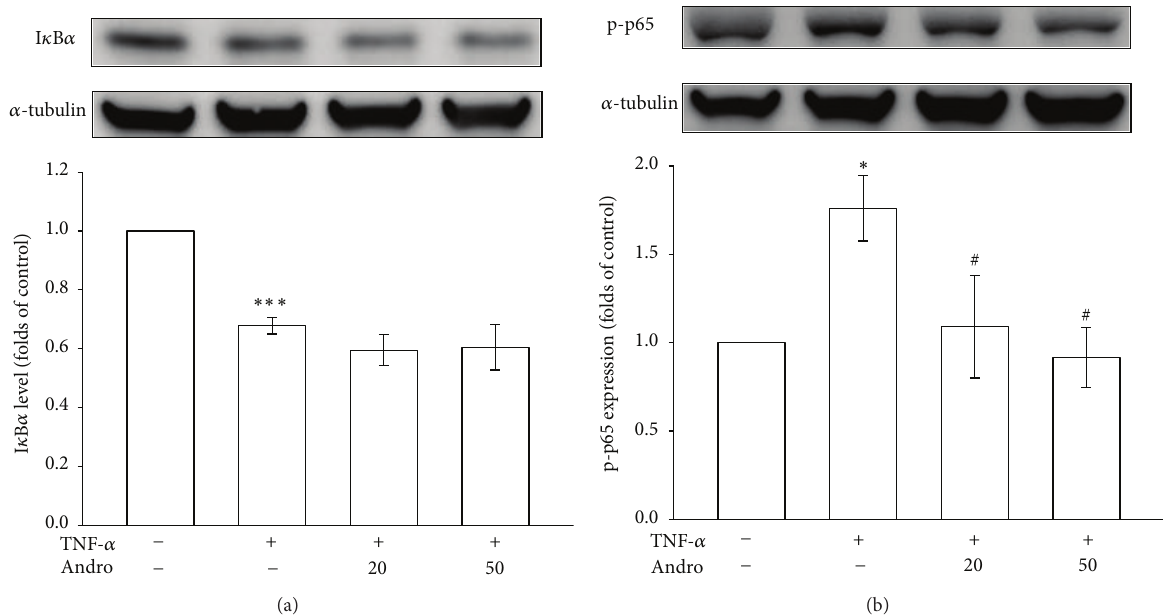
Figure 4: Effects of andrographolide on I 𝜅 B 𝛼 degradation and p65 activation in TNF- 𝛼 -stimulated VSMCs. The VSMCs were treated with PBS (resting group) or pretreated with andrographolide (20 and 50 𝜇 M) or an equal volume of DMSO (solvent control) for 20 min, and TNF- 𝛼 (10ng/mL) was subsequently added for 30min. (a) I 𝜅 B 𝛼 degradation and (b) p65 phosphorylation were evaluated as described in Section 2. ∗ 𝑃 < 0.05 and ∗∗∗ 𝑃 < 0.001 compared with the resting group; # 𝑃 < 0.05 compared with the TNF- 𝛼 group. The data are presented as the mean ± SEM ( 𝑛 = 3